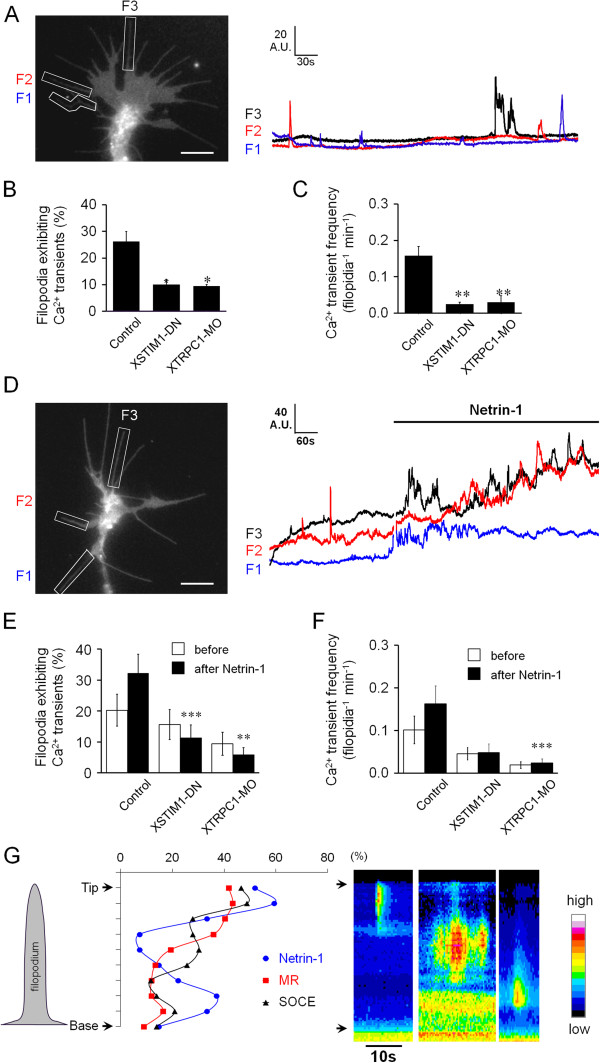
STIM1/TRPC1-dependent SOCE mediates the spontaneous and netrin-1-potentiated filopodial Ca2+ entries. (A) Left panel; a Lck-GCaMP3 fluorescent Ca2+ image of a Xenopus spinal growth cone showing three ROIs (F1, F2 and F3) encompassing the filopodia used to measure fluorescent intensities over time (right panels). Scale bar, 10 μm. The incidence (B) and the frequency (C) of the spontaneous filopodial Ca2+ transients were significantly attenuated by XSTIM1-DN (n = 30) or XTRPC1-MO (n = 30), when compared to the control (n=34; *P < 0.001 and **p < 0.005, Student’s t-test). Values represent mean ± s.e.m. (D) A Lck-GCaMP3 fluorescent Ca2+ image of a growth cone showing three ROIs (left panel) and their representative traces of Ca2+ signals in three filopodia (F1, F2, F3) before and after bath application of netrin-1 (10 ng/ml) (right panel) in the presence of Sp-cAMP (25 μM). Scale bar, 10 μm. (E-F) Netrin-1 potentiated the incidence (E) and the frequency (F) of filopodial Ca2+ transients in spinal growth cones (control; n = 14) and this potentiation was abolished by XSTIM1-DN (n = 8) and XTRPC1-MO (n = 10). **P < 0.005 and ***p < 0.05 (Student’s t-test). Values represent mean ± s.e.m. (G) Filopodia tips are the major site of initiation of filopodial Ca2+ entry as revealed by kymographs of Ca2+ signals in filopodia using Lck-GCaMP3 in modified Ringers saline (MR; n = 67), netrin-1 exposure (n = 27) and Ca2+ re-addition after depletion (SOCE; n = 43). The y axis represents the path distance along the filopodia divided into 10 portions and the x axis represents time. The arrows denote the tip and base of filopodia.